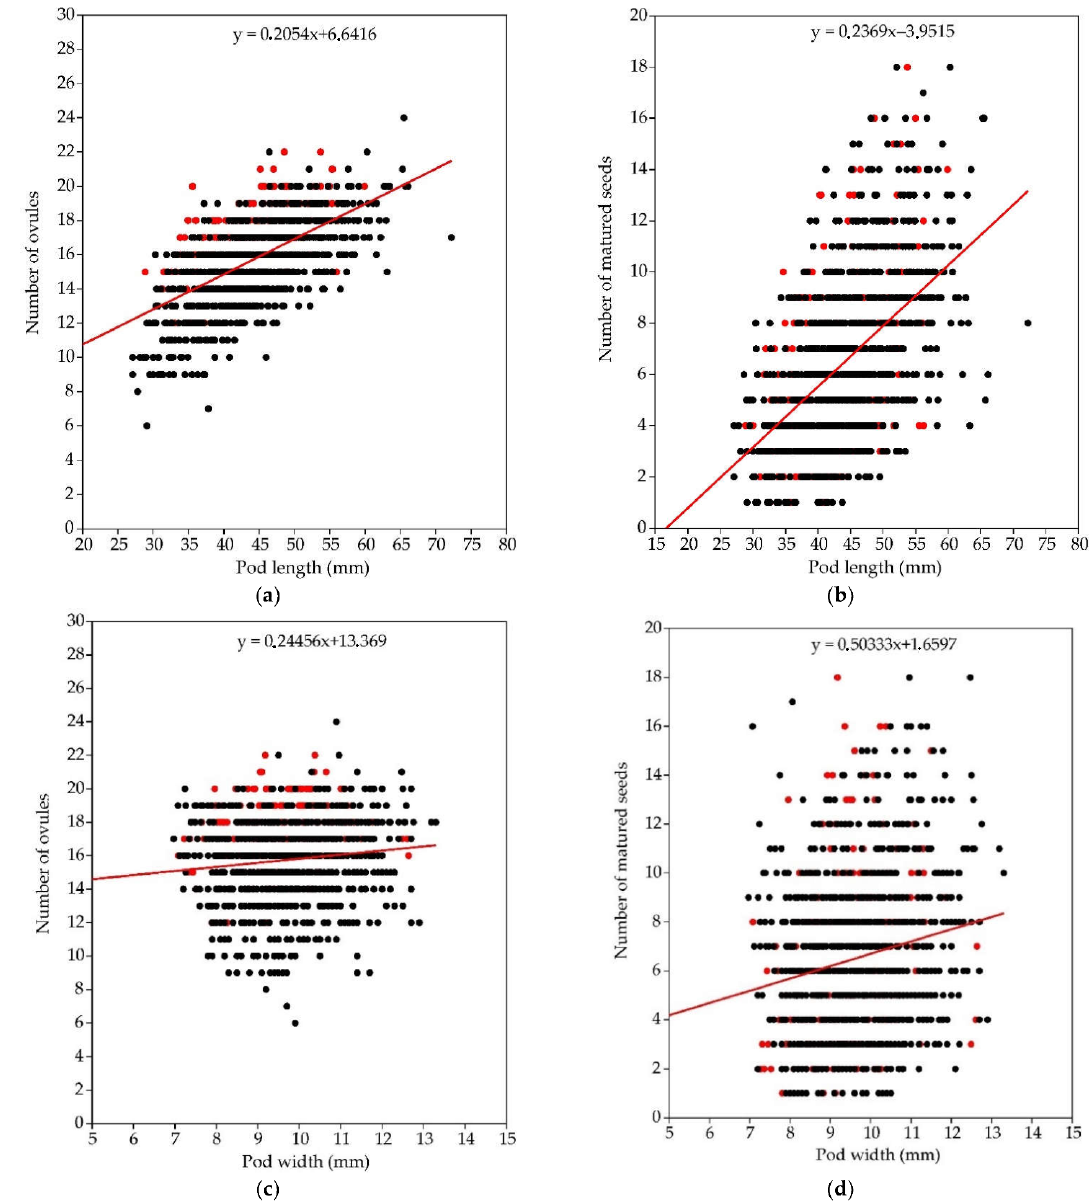
Figure 3. Relationship between pod length and number of ovules ( a ), pod length and number of mature seeds ( b ), pod width and number of ovules ( c ), and pod width and number of mature seeds ( d ). Red dots indicate data from the native range and black dots from the invasive